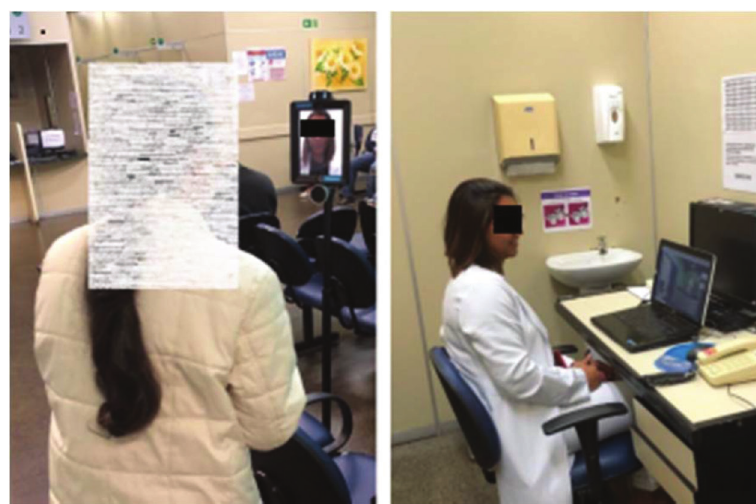
Figure 1 - Screening of incoming patients with or without respiratory symptoms using the